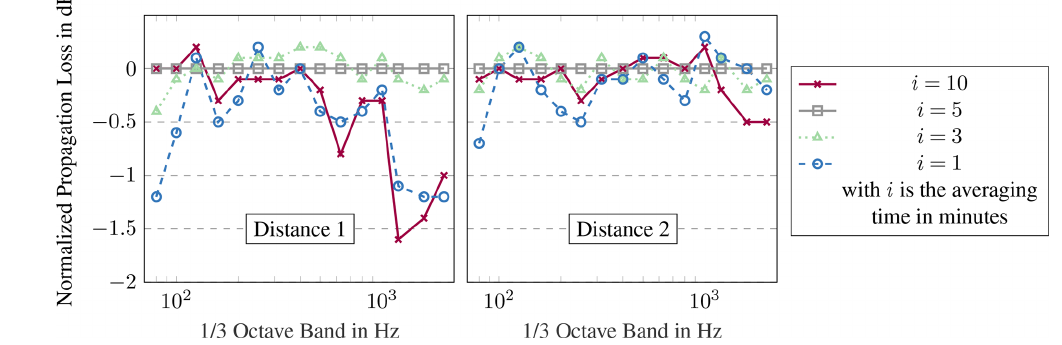
Figure 16. Comparison of measured sound propagation losses between 178 and 535m and between 178 and 845m for the different averaging times i per one-third octave band. The data are normalised to the results averaged over